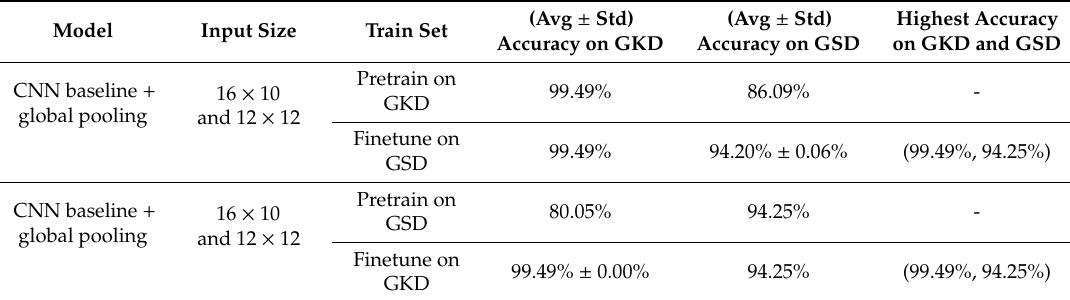
Table 4. Performance of multi fully-connected